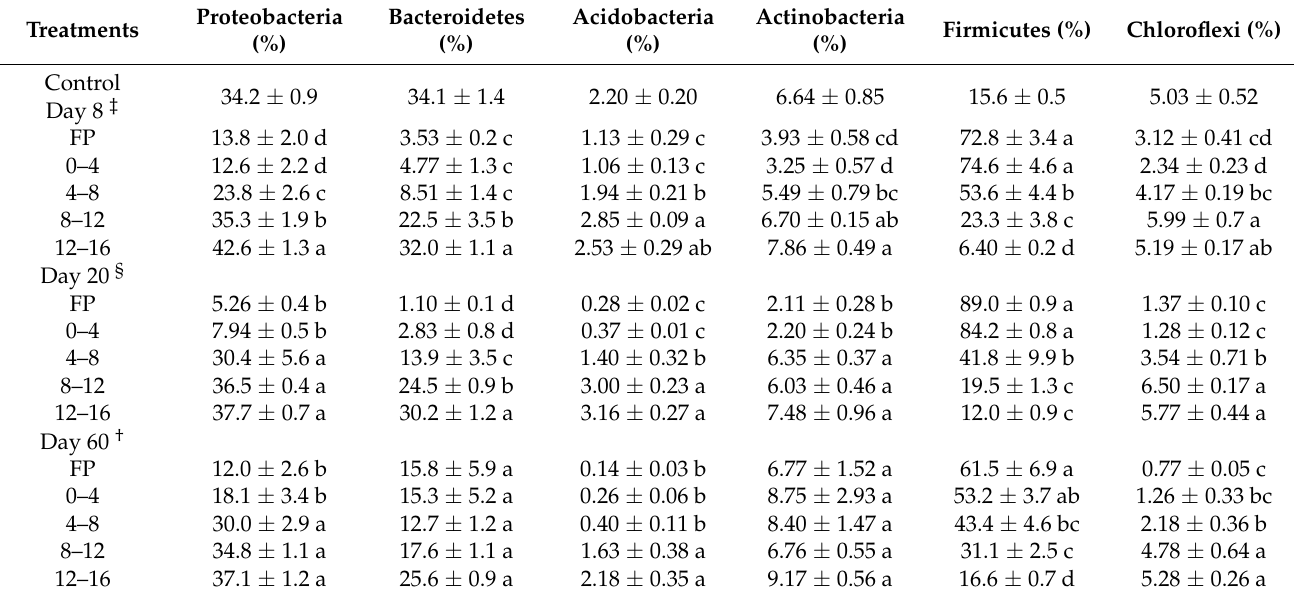
Table 2. The abundance of dominated bacteria phyla under different treatments and incubation times for Dangtu (DT) soil. Data are means ± SE, n =